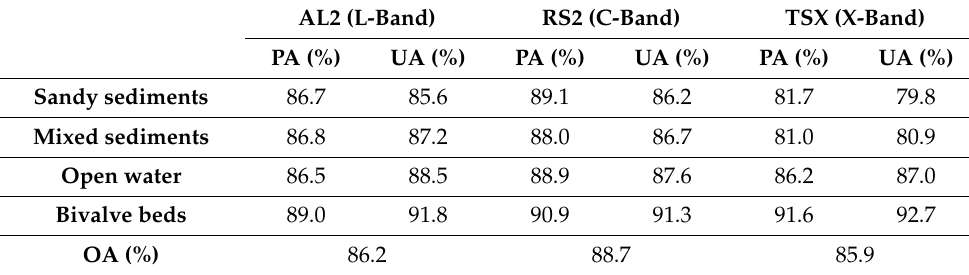
Table 2. Accuracy assessments for the classification results derived from AL2 L-band, RS2 C-band and TSX X-band SAR data. PA: Producer’s Accuracy; UA: User’s Accuracy; OA: Overall Accuracy. AL2 (L-Band) RS2 (C-Band) TSX (X-Band) PA (%) UA (%) PA (%) UA (%) PA (%) UA (%) Sandy